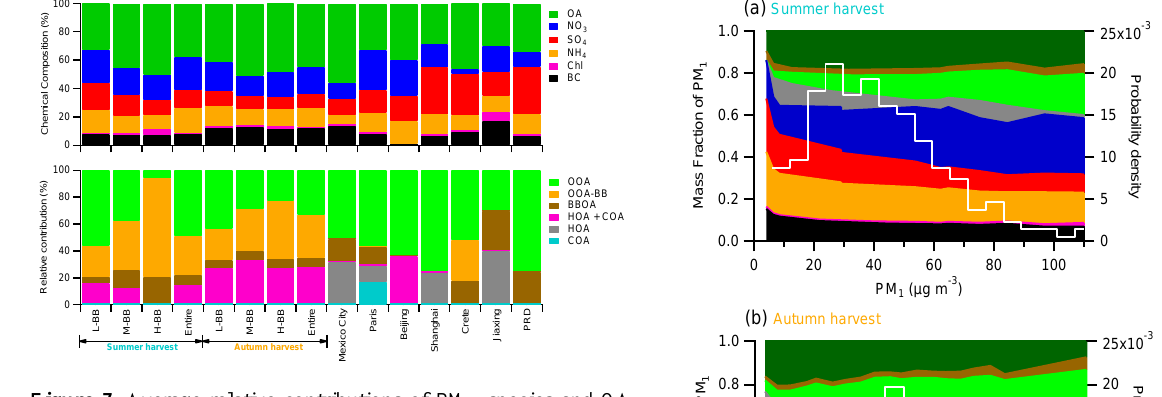
Figure 7. Average relative contributions of PM 1 species and OA components for a low biomass-burning period (L-BB), medium biomass-burning period (M-BB), and high biomass-burning period (H-BB), as well as entire period during the harvest seasons and other sites including megacities (Mexico City, Paris, Beijing, and Shanghai), suburban area (Jiaxing), remote background site (Crete), and PRD (Pearl River delta, China). Note that OOA in this plot in- cludes OOA 2 -BBOA in Paris.